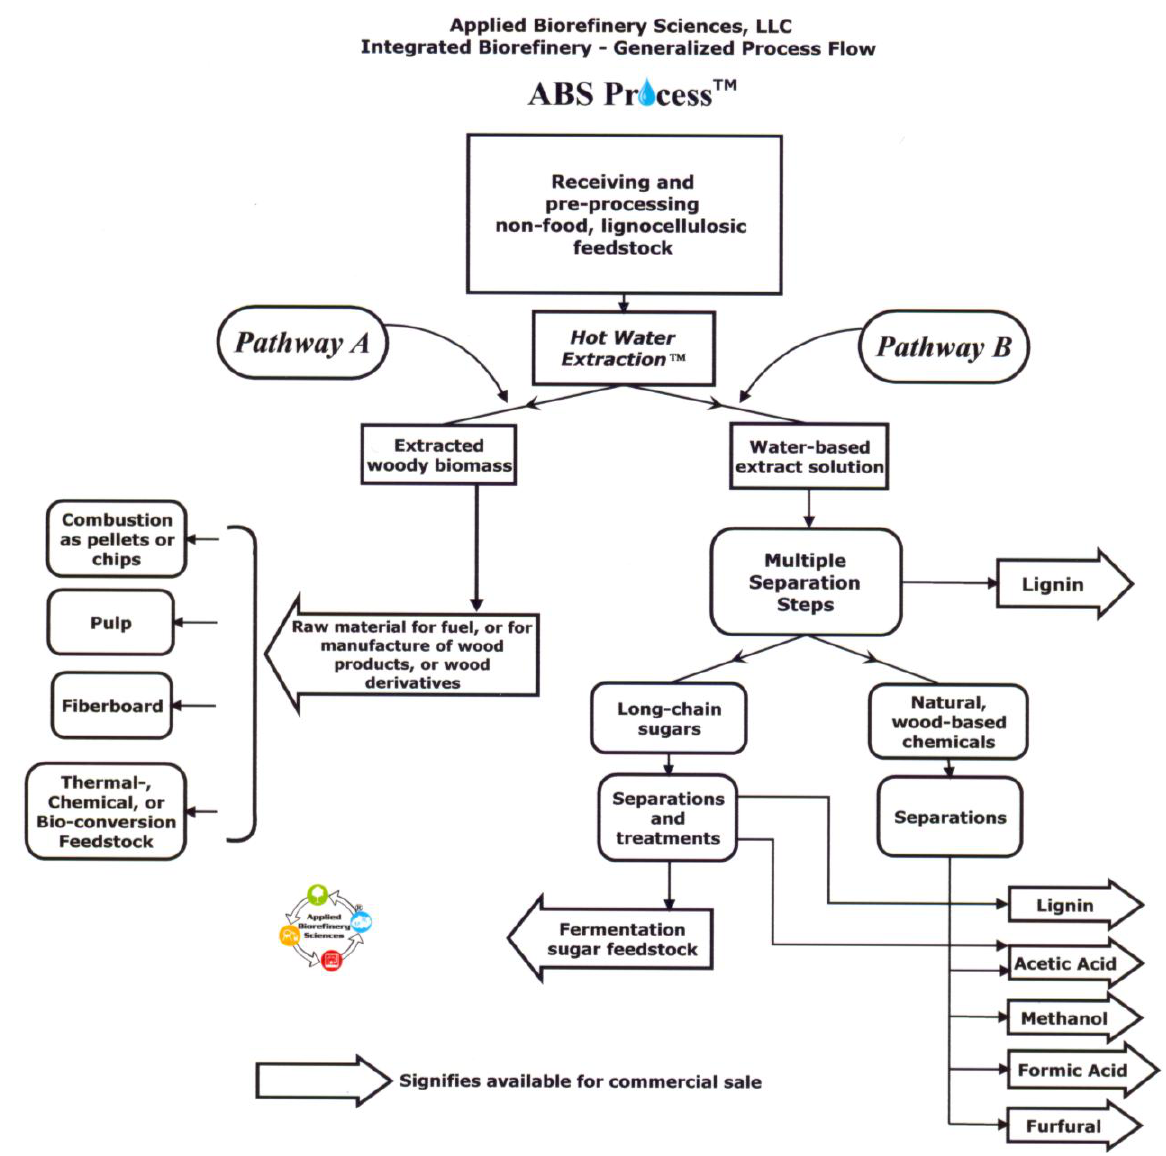
Figure 4. The ABS Process